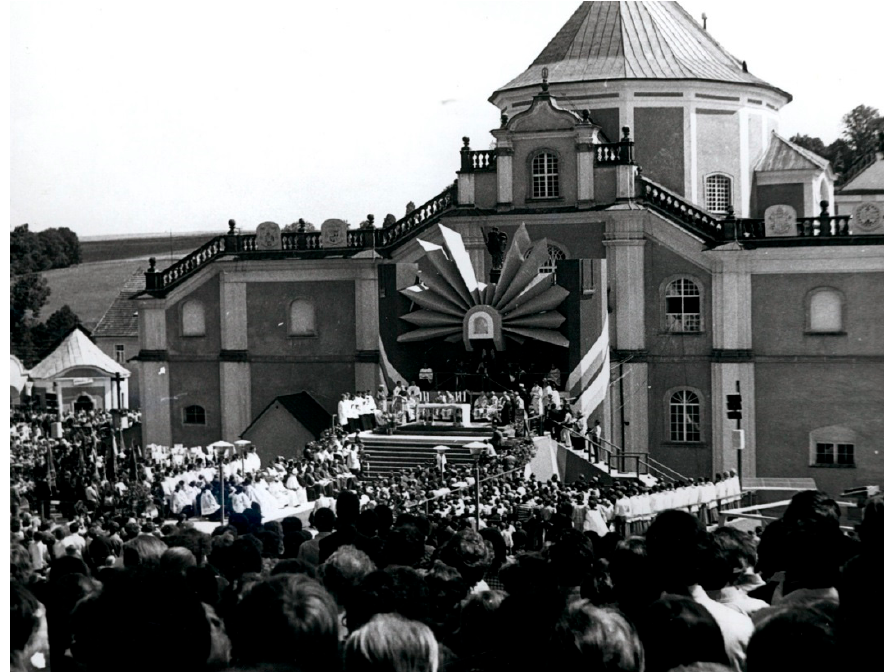
Figure 8. The ceremony of the coronation of the statue of Our Lady, Queen of Families in Wam- bierzyce (17 August 1980) (photo: Archwium of the Sanctuary of Our Lady Queen of Families in